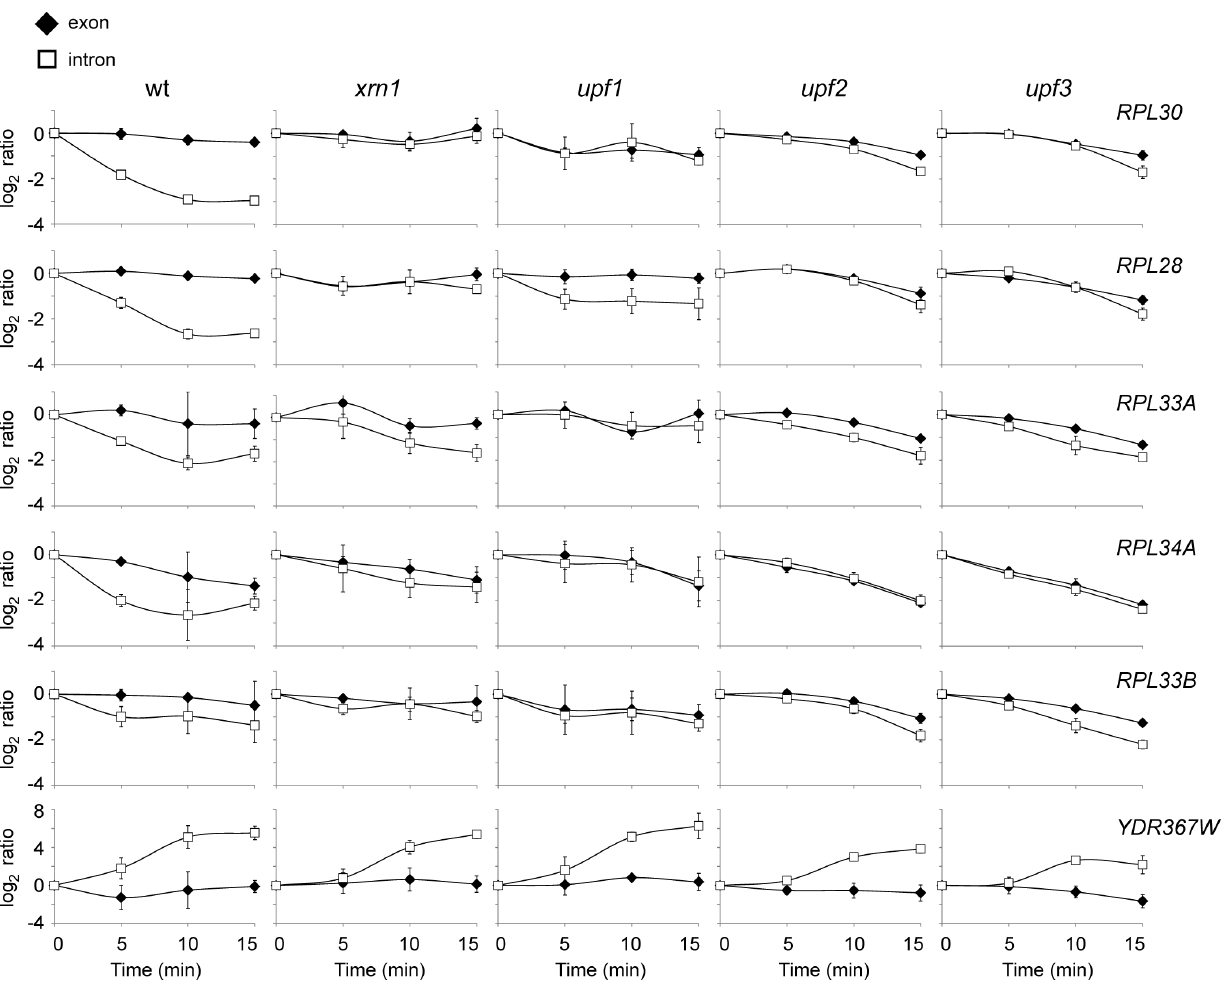
Figure 5. Kinetics of ribosomal protein pre-mRNAs during osmotic stress in cells containing mutations in NMD components. The behaviour of the transcripts RPL30 , RPL28 , RPL33A , RPL33B , RPL34A and YDR367W after 0, 5, 10 and 15 minutes treatment with 0.4M NaCl were examined in the wild-type, upf1 , upf2 and upf3 and xrn1 mutants by quantitative RT-PCR, as described in Figure 2A. Data and errors bars represent the average and standard deviation of 3 independent